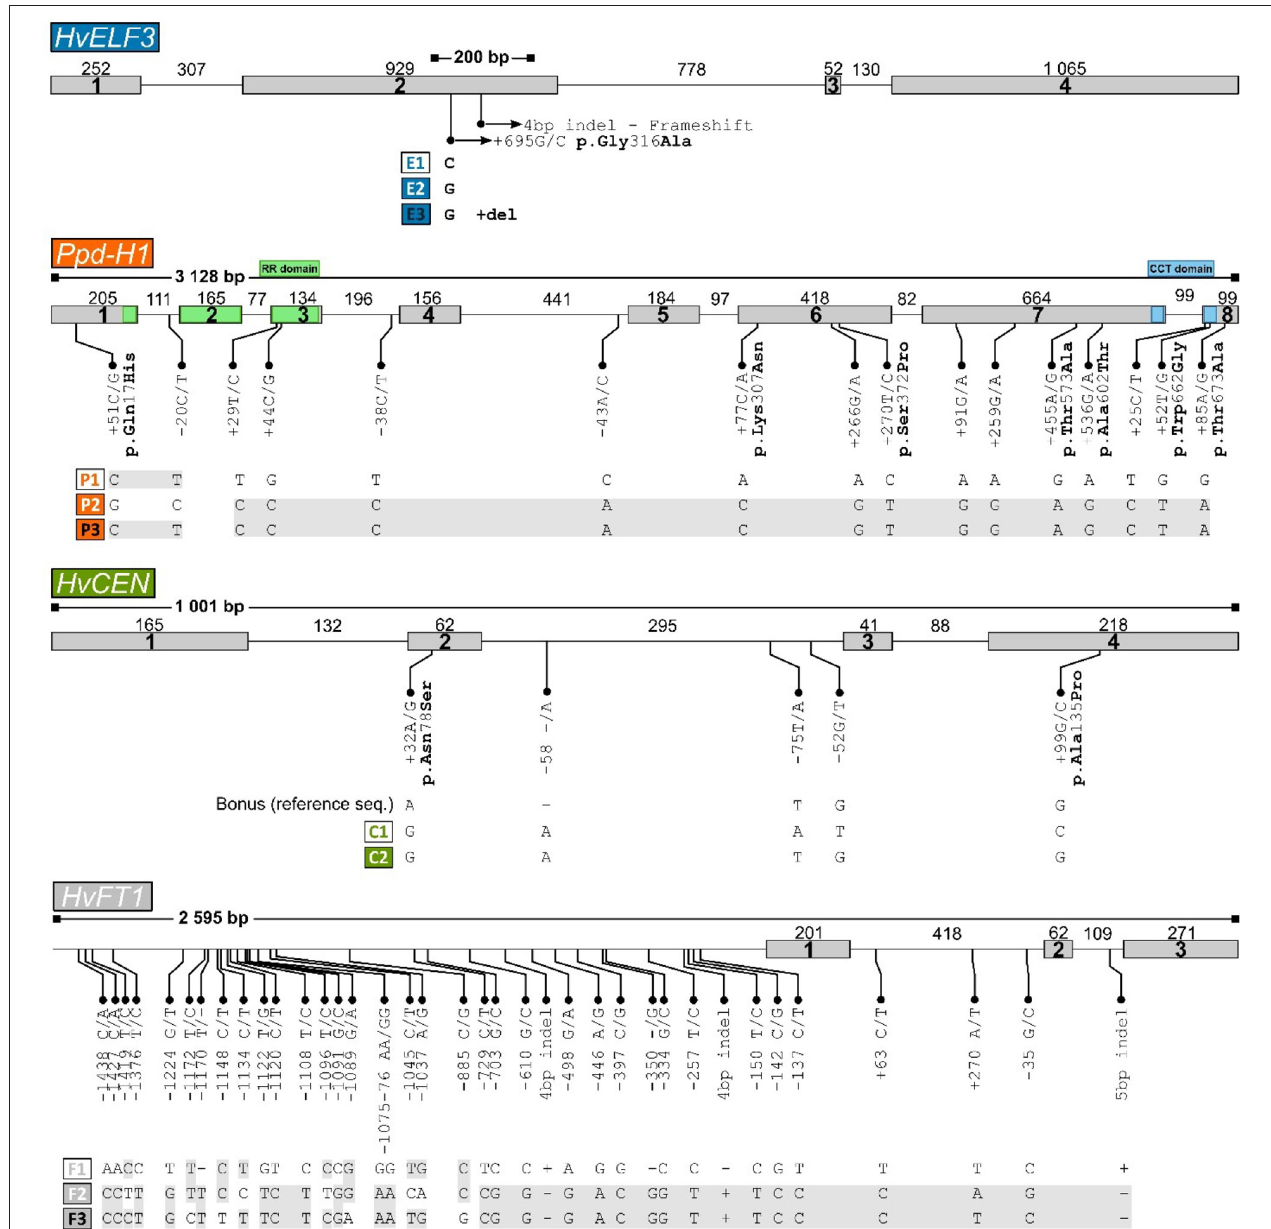
FIGURE 3 | Structure of the four genes re-sequenced, HvELF3 , Ppd-H1 , HvCEN , and HvFT1 , with polymorphisms constituting haplotypes identified. Exons are shown as boxes (size in base pairs below) and introns as lines (size in base-pairs above). The size of the region sequenced is shown in base pairs above the intron-exon structure with lines with filled boxes at each end. For each gene, the identified haplotypes are indicated below the corresponding line drawings. In the structure of the HvELF3 ( Mat-a ) gene the location of the 4 bp “Mari” deletion is indicated with an arrow. Color coding of genes is the same in all figures.